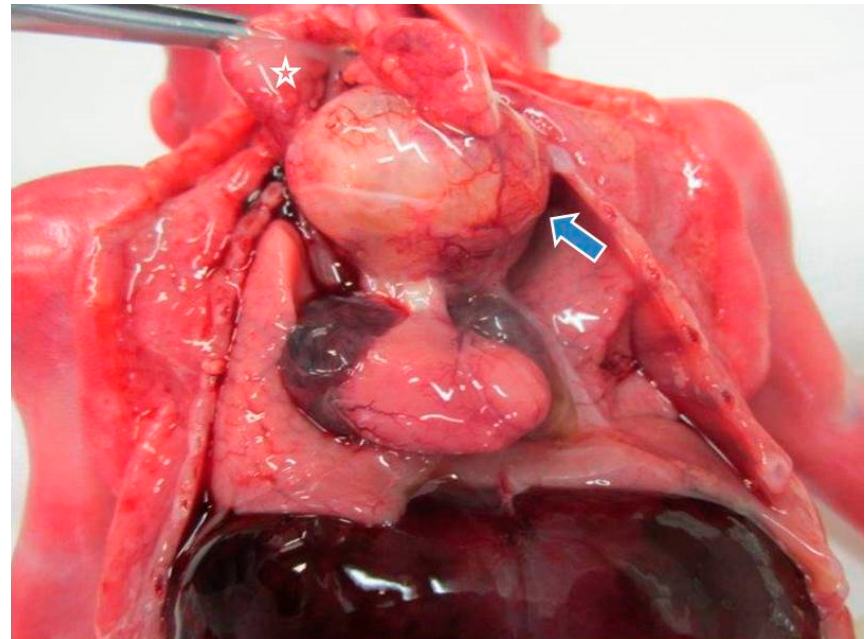
Figure 2. Gross features of mediastinal teratoma (blue arrow) at autopsy: the tumor was located underneath the thymus (star) and above the heart. Microscopically, the nodule showed the typical features of a teratoma, composed of mature and immature tissue from the three embryonic germinal layers. Endodermal elements were predominant with ciliated respiratory epithelium, gastric mucosa, and glands in a lobular pattern (Figure 4). A miniature fetal liver (endoderm origin) with hematopoiesis (mesoderm) was focally identified. The mesodermal component was represented by choroid pigmented epithelium, renal structures, cartilage, abundant areas of immature mesenchyme, and smooth muscle. Neuroectoderm was abundant and characterized by immature neuroepithelium